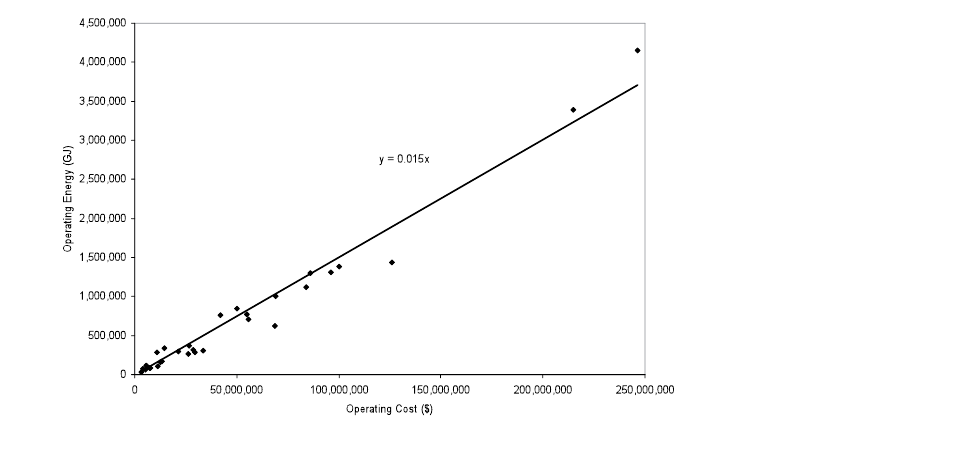
Figure 3: Operating energy v operating cost